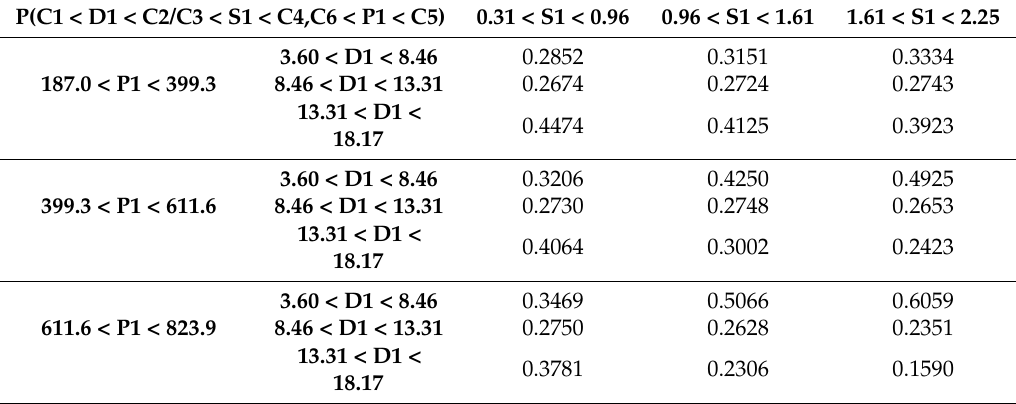
Table 8. Probabilities of the groundwater buried depth falling into different ranges given that the irrigation volume of the surface water and precipitation fall into different